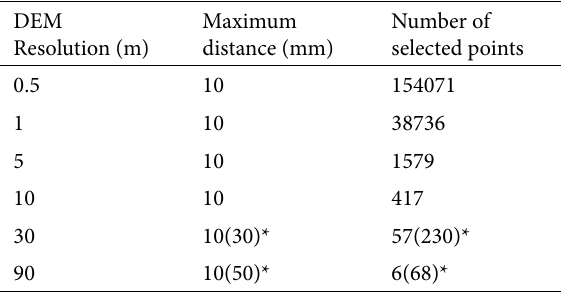
Table 1. The number of selected points for each DEM resolution out of the total 76 940 341